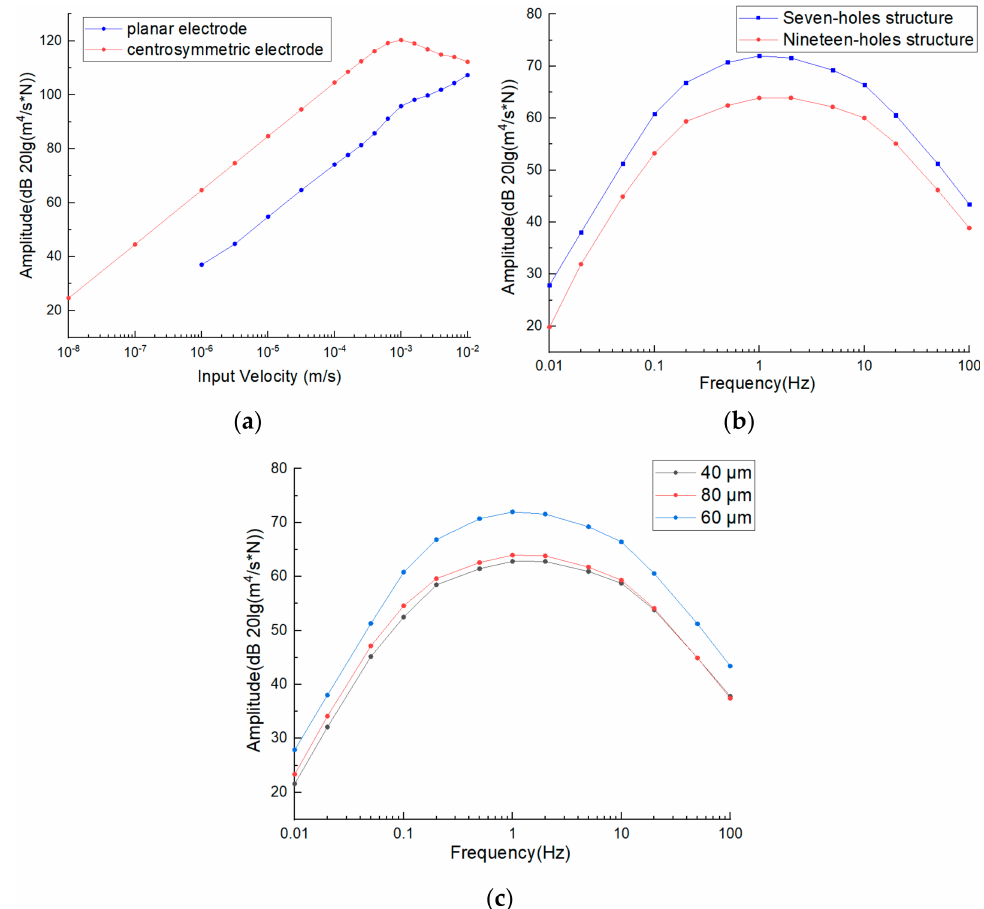
Figure 3. Simulation results: ( a ) output current vs. input velocity of the electrochemical seismic sensors based on the integrated structure of four centrosymmetric micro electrodes vs. four planar micro electrodes. Amplitude frequency responses of the electrochemical seismic sensors based on the integrated structure of four centrosymmetric micro electrodes with variations in arrangements of flow holes ( b ) and anode width ( c